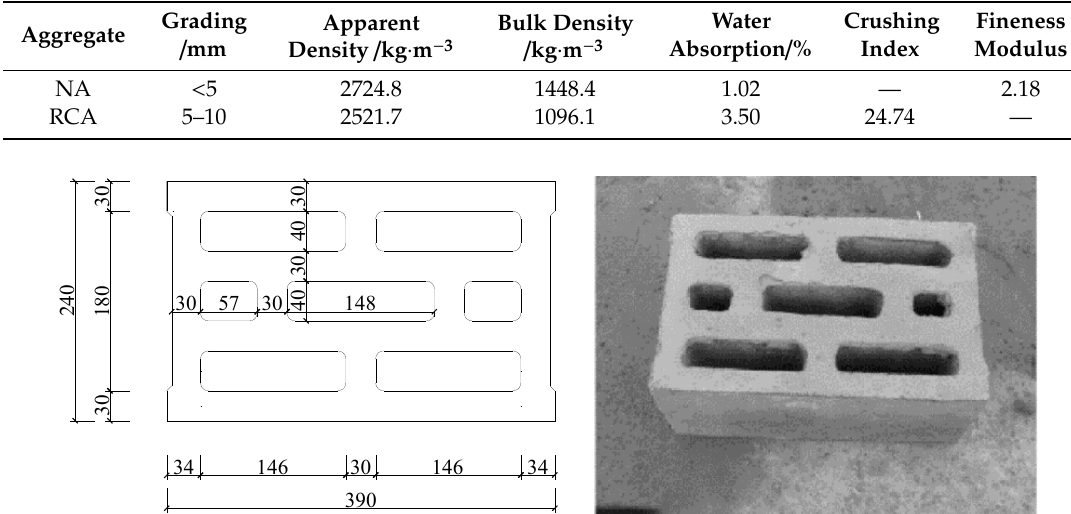
Figure 3. The dimension of recycled concrete hollow block.